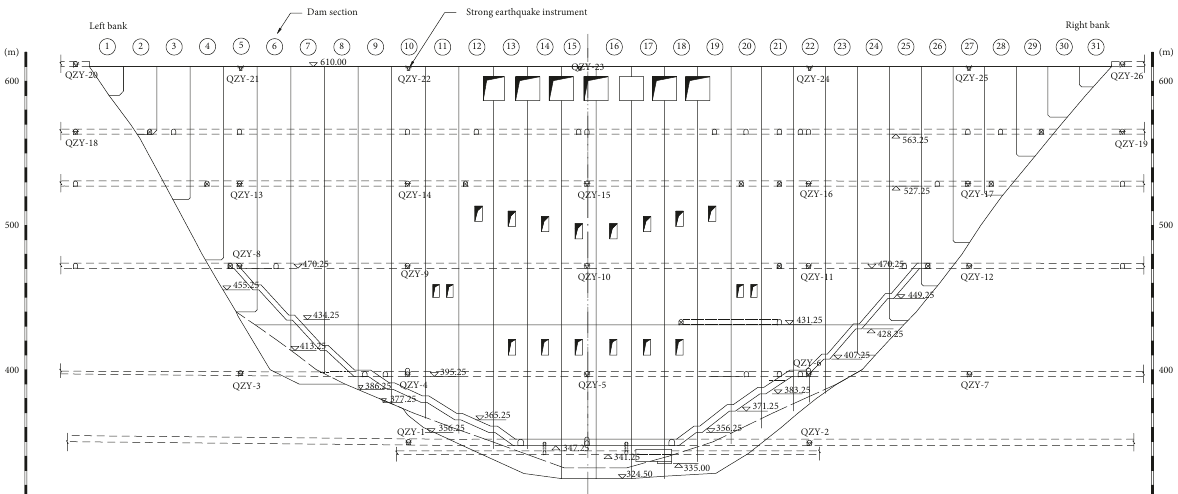
Figure 8: Site layout of the monitoring system for the strong motion seismograph.